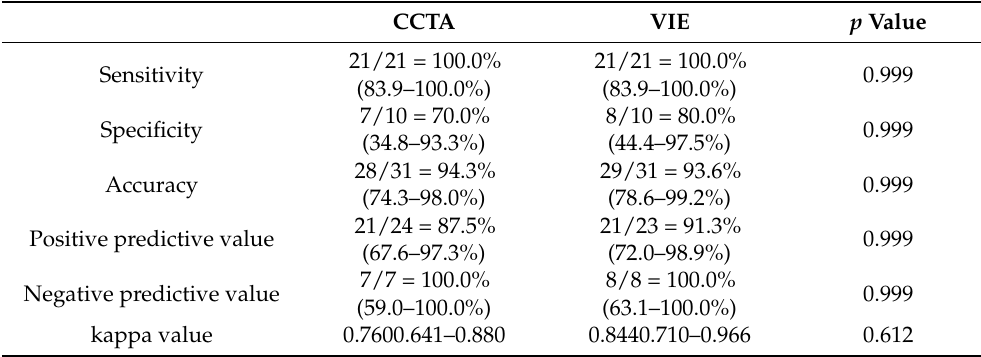
Table 5. Diagnostic performance of CCTA versus VIE in detecting coronary artery disease in 31 vessel segments with non-calcified plaques, using ICA as the gold standard.